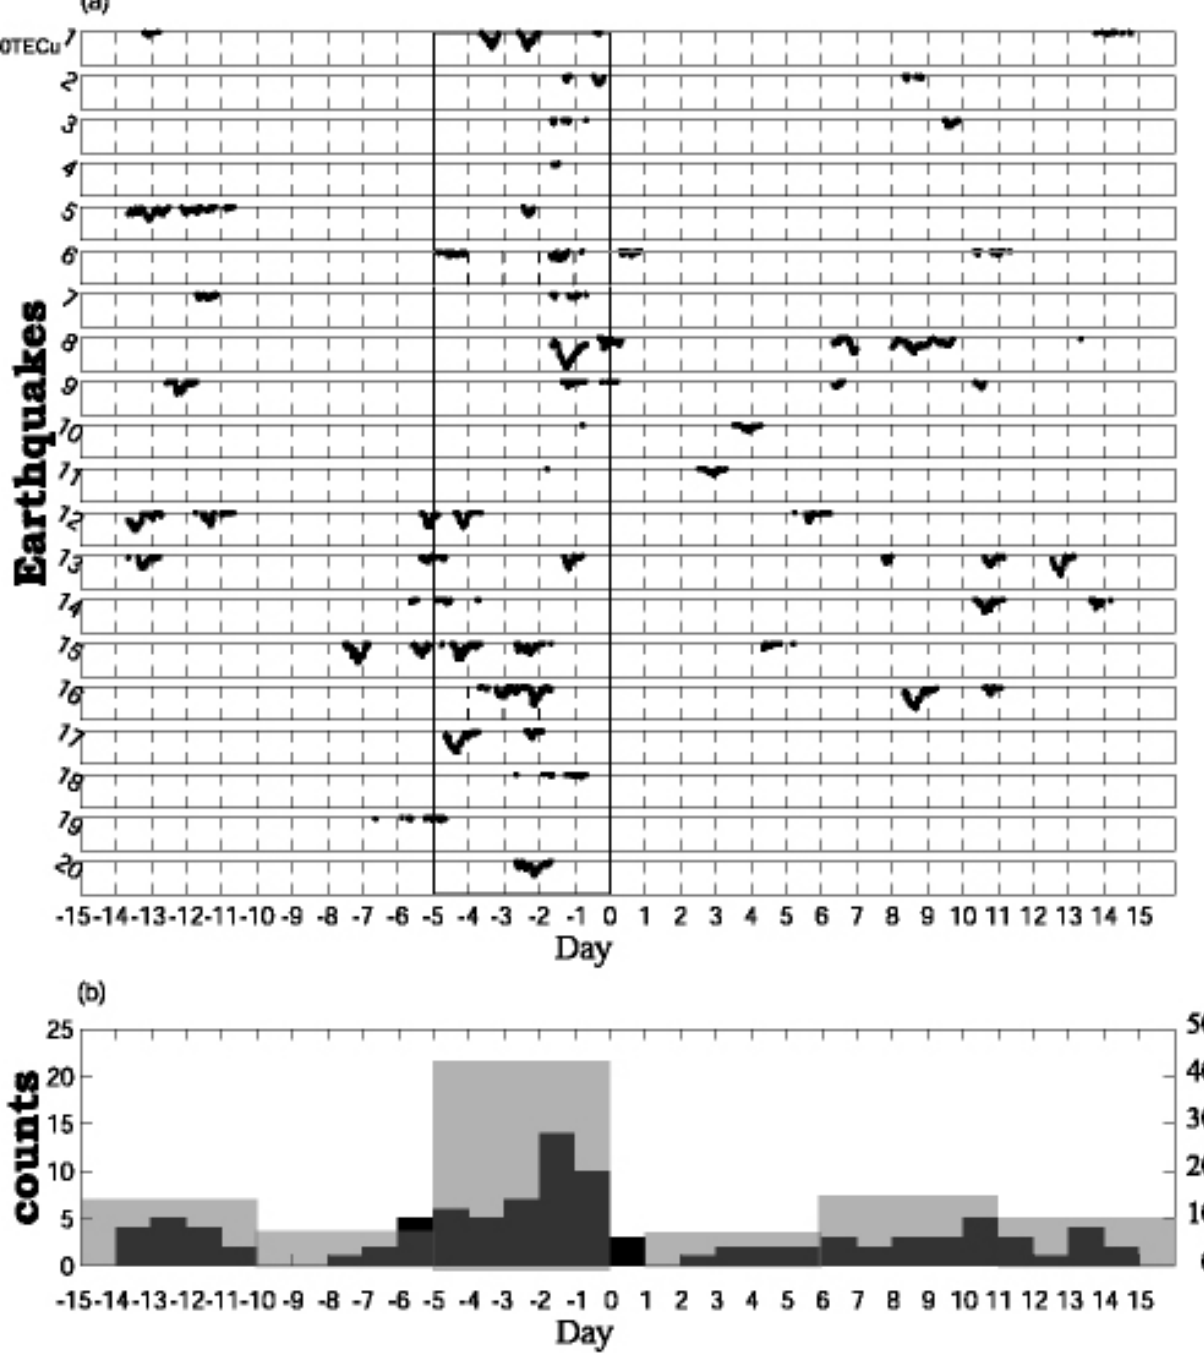
Fig. 5. The same plots as in Fig. 4 but after removing the anomalies related to the M5.0s earthquakes and the geomagnetic